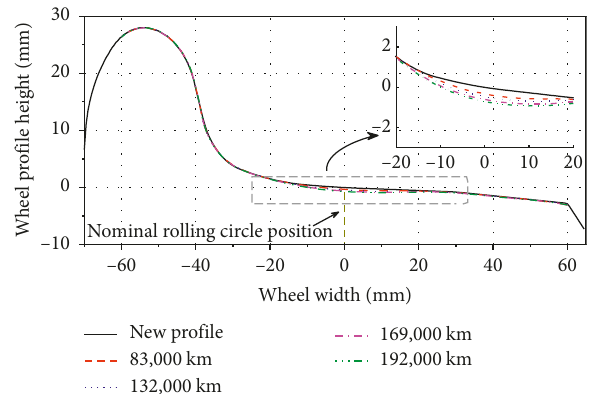
Figure 9: Comparison of measured wheel profiles with different travelling distances.